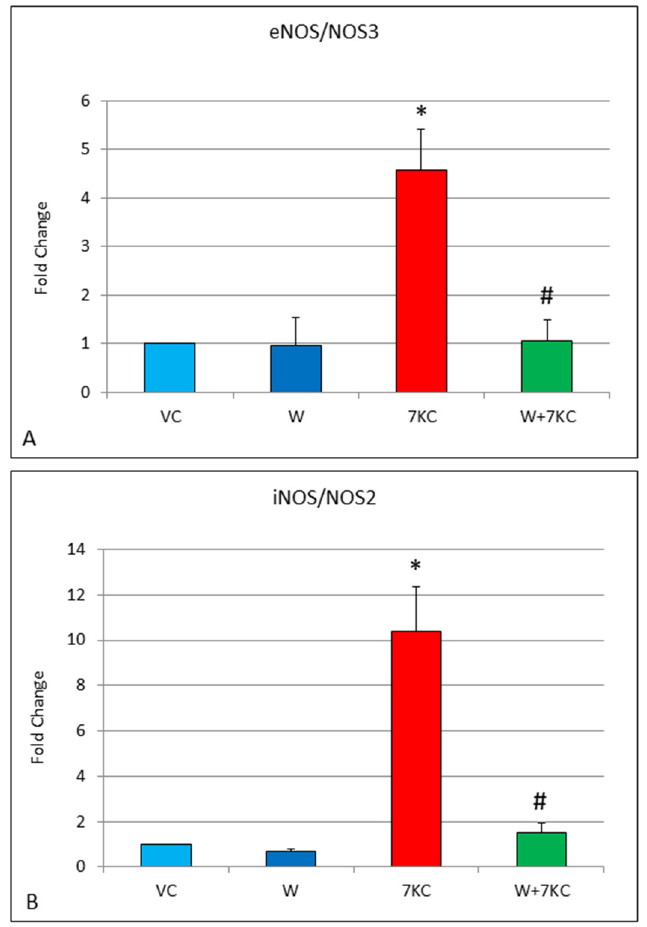
Figure 5. ( A , B ): Effect of withanolide A and 7KC on eNOS and iNOS mRNA expression, determined by real time RT-PCR. A 4.6-fold increase in eNOS, and a 10.4-fold increase in iNOS was found after treatment of endothelial cells with 7KC. The increases were significantly reduced by withanolide A. Data are represented as mean ± SD ( n = 4). * Significant difference compared to controls. # Significant difference compared to 7KC (all p < 0.01).